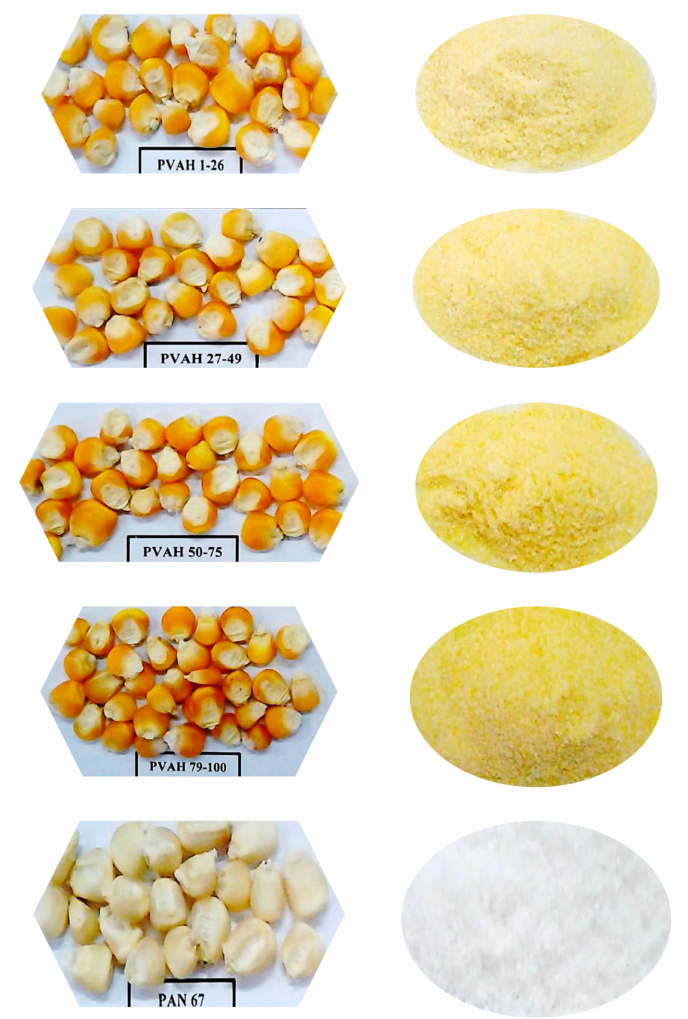
Figure 1. Provitamin A biofortified maize grain and their maize meal. PVAH = provitamin A hybrid; PAN67-representative white